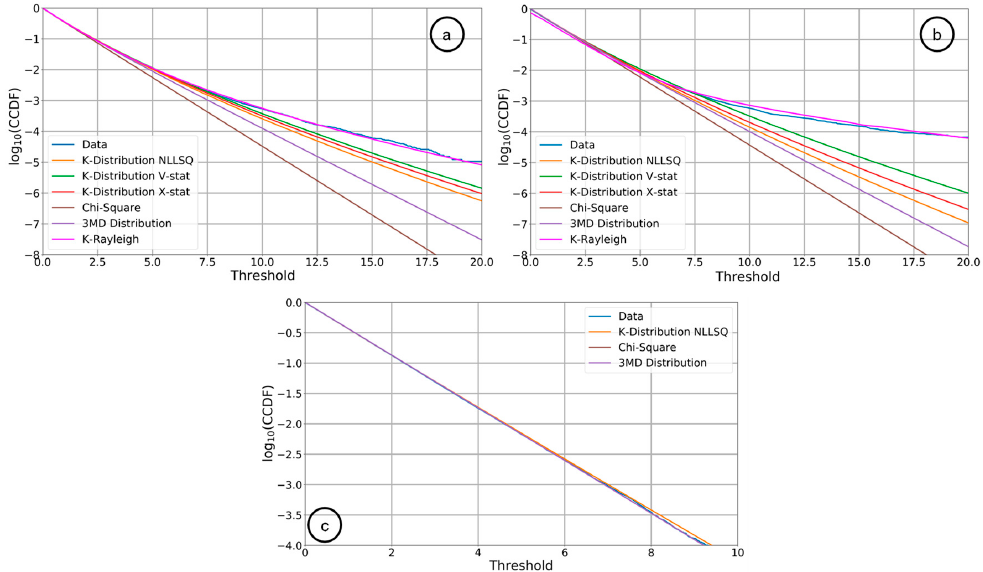
Figure 27. Logarithmic CCDFs of different distribution functions plotted for ( a ) near ( b ) mid and ( c ) far range. These plots are generated from the same data used for generating the plots shown in Figure 24.